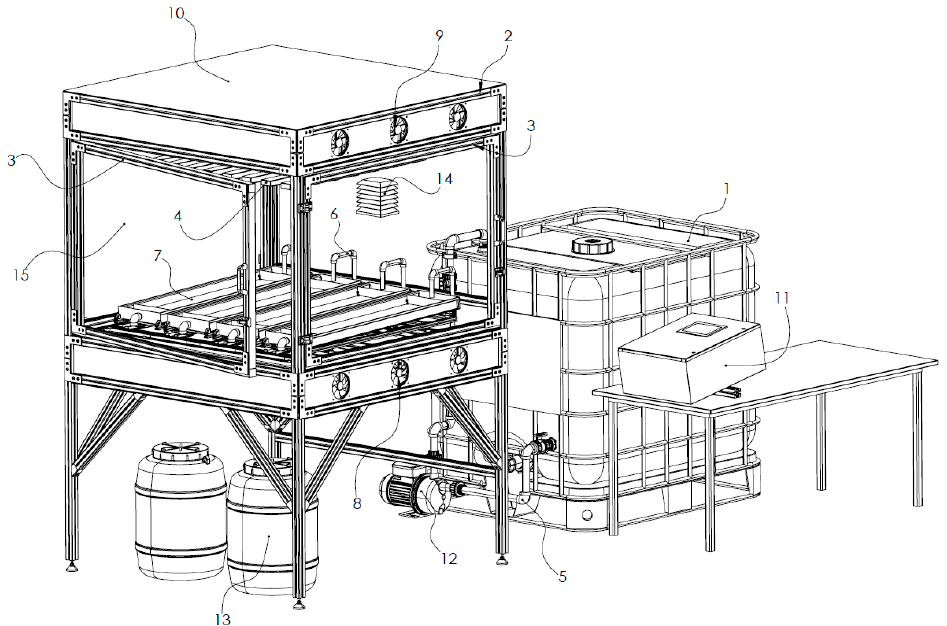
Figure Figure 2. Hydroponic fodder cultivation and research bench scheme: 1—irrigation tank, 2—alumi ‐ num profile, 3—door, 4—aluminum frame with LED system installed, 5 and 6—irrigation piping and connections, 7—growth tray unit equipped with a system for monitoring changes in the mass of cultivated plants, 8—air intake system, 9—exhaust air ventilation system, 10—plastic cover plate, 11—process control unit, 12—irrigation pump, 13—seed soaking container, 14—measurement unit with microclimate sensors installed in it, 15—plexiglass panels.